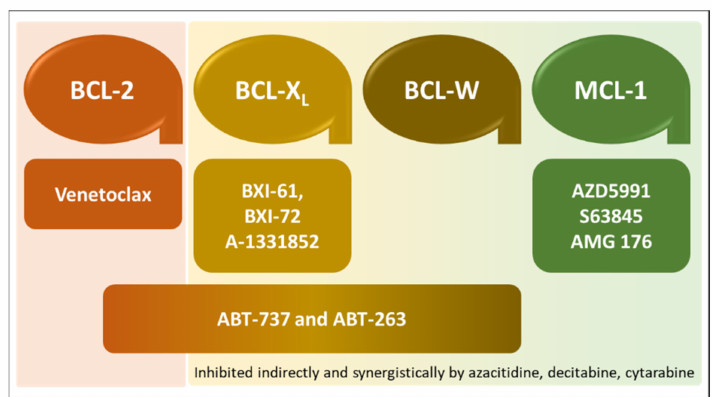
Figure 1. Small-molecule BH3-mimetic drugs in clinical use or under clinical evaluation. Inhibitors and their selectivity for anti-apoptotic BCL-2 family proteins are depicted with matching colors. ABT-737 and ABT-263 have broad selectivity, which spans BCL-2, BCL-X L , and